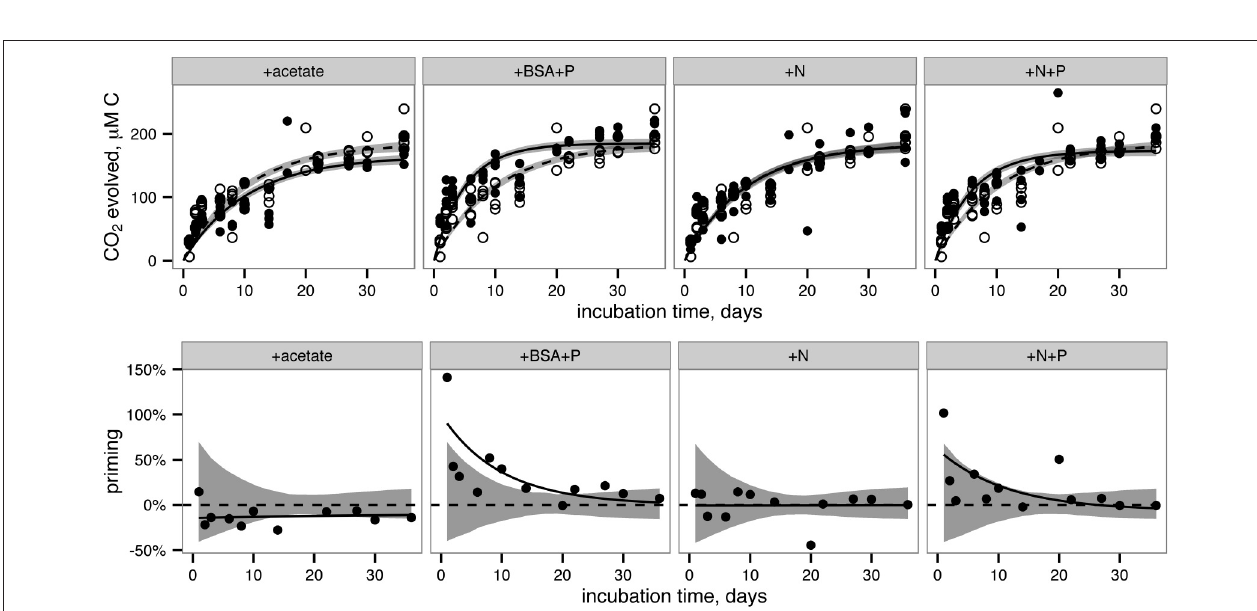
FIGURE 2 | Remineralization of total OC (top row) and particulate OC (bottom row). Lines indicate nonlinear least squares regressions to Equation 2 (provided in Methods). Filled circles and solid lines indicate data from each treatment, as indicated across the top panels. Open circles and dashed lines indicate control data and are repeated in each panel for reference.